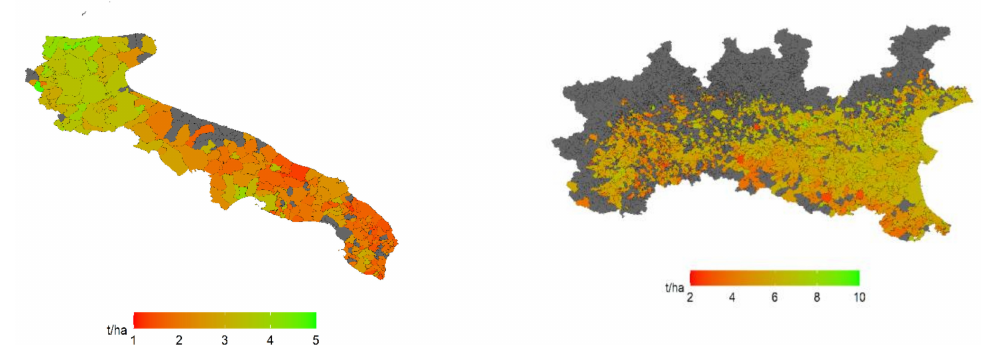
Figure 2. Average wheat yields (tons / hectares) in Puglia (PG) ( left ) and the Po River Basin District (PRBD) ( right ), at the municipality level over the study period